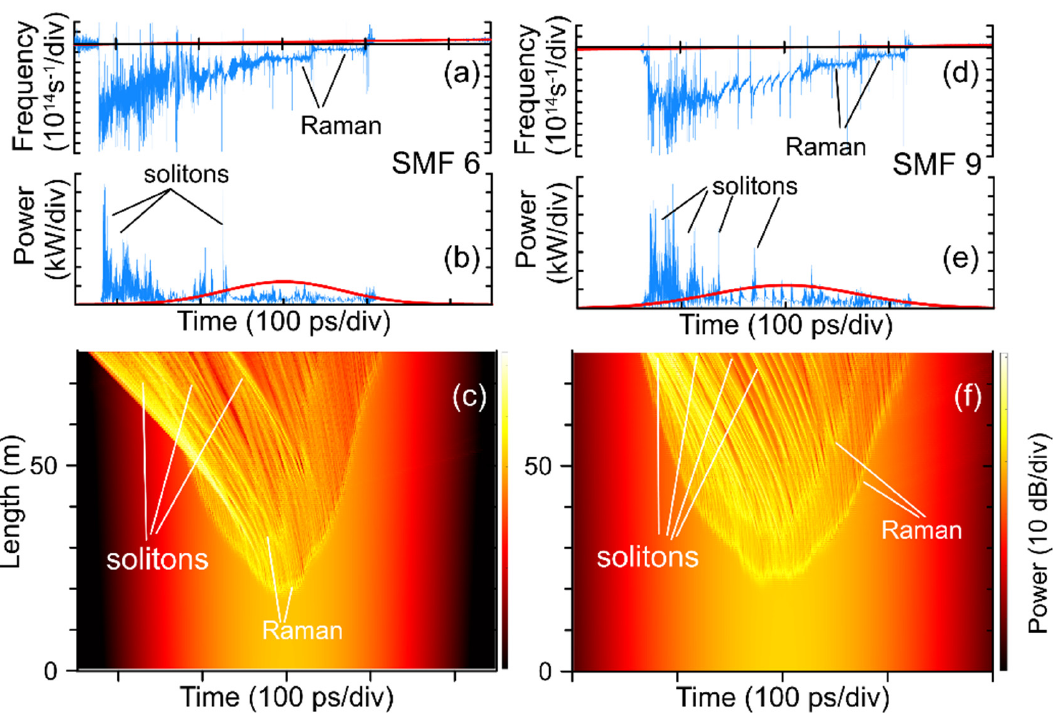
Figure 6. Frequency modulation of radiation at the input (red) and output (blue lines) from SMF6 ( a ) and SMF9 ( d ) fibers. Time envelopes the initial pulse (red) and output radiation (blue lines) from SMF6 ( b ) and SMF9 ( e ) fibers. The evolution of the pulse power during the propagation of radiation along the fiber SMF6 ( c ) and SMF9 ( f ).